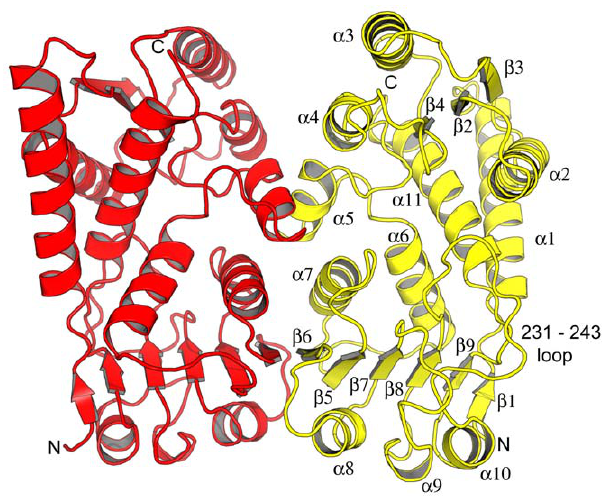
Figure 2. Structure of Pa FolD. Cartoon representation of a homodimer of Pa FolD with secondary structure labeled. The interface occurs between a 5, a 7 and b 6 of partner subunits.